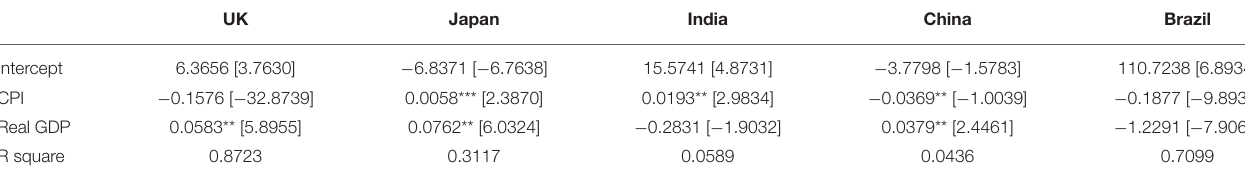
TABLE A1 | Robustness